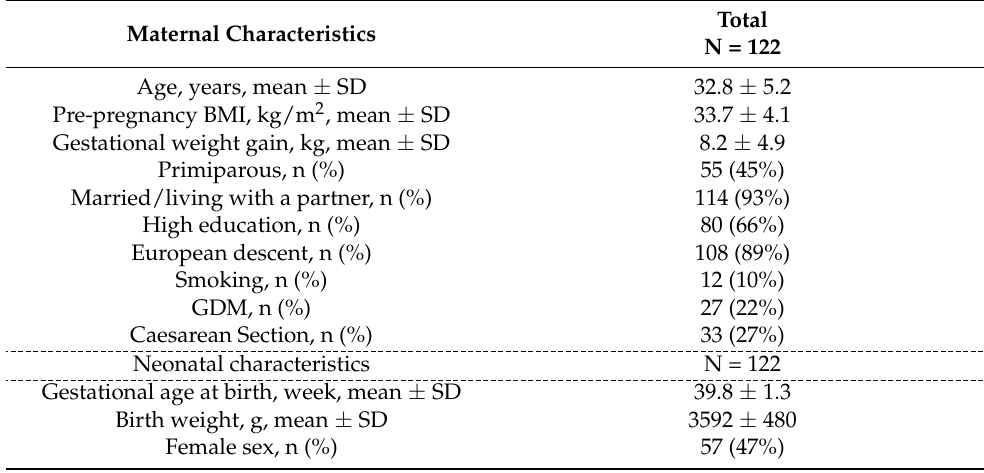
Table 1. Characteristics of the study sample.